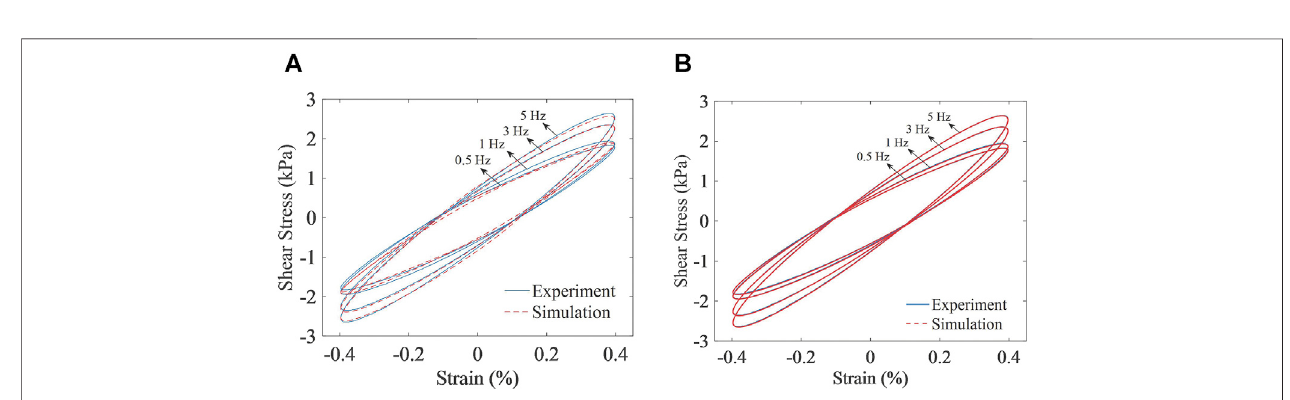
FIGURE 7 | Simulation data and experimental data under different frequencies: (A) Bouc-Wen model and (B) modi fi ed Bouc-Wen model.